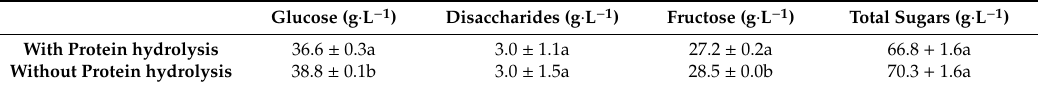
di ff erence at p < 0.05.